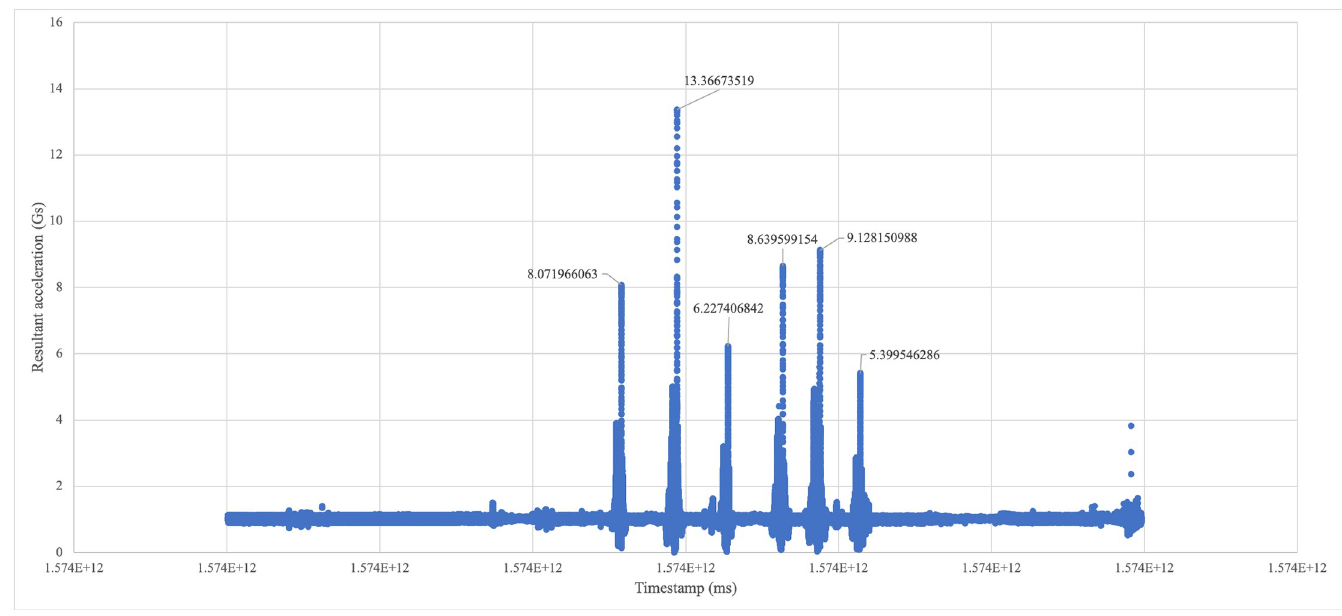
Fig 2. Shimmer scatter plot generated from Shimmer excel data.